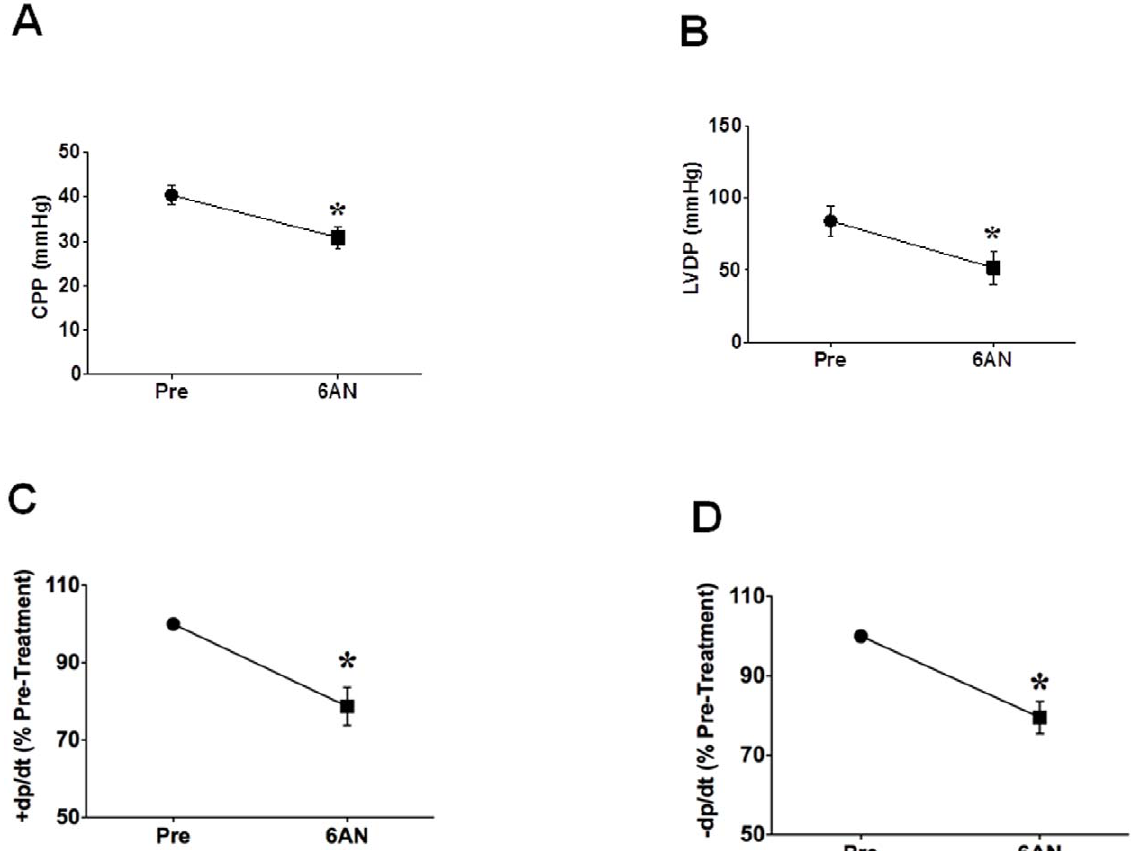
Figure 2. Inhibitory effects of 6AN on myocardial function in isolated rat hearts. 6AN (5 mM) was applied to the hearts in vitro for 10 minutes. A: perfusion of the heart with 6AN decreased coronary perfusion pressure (CPP). B: summary data indicate inhibition of left ventricle developed pressure by 6AN. C and D: summary data indicate inhibition of + dp/dt and 2 dp/dt by 6AN. Hemodynamic measurements were continuously done during the experiment, but measurement taken just prior to perfusing the heart with 6AN (Pre) and 10 minutes after 6AN perfusion (6AN) are reported. *P , 0.05 vs. control (Pre).